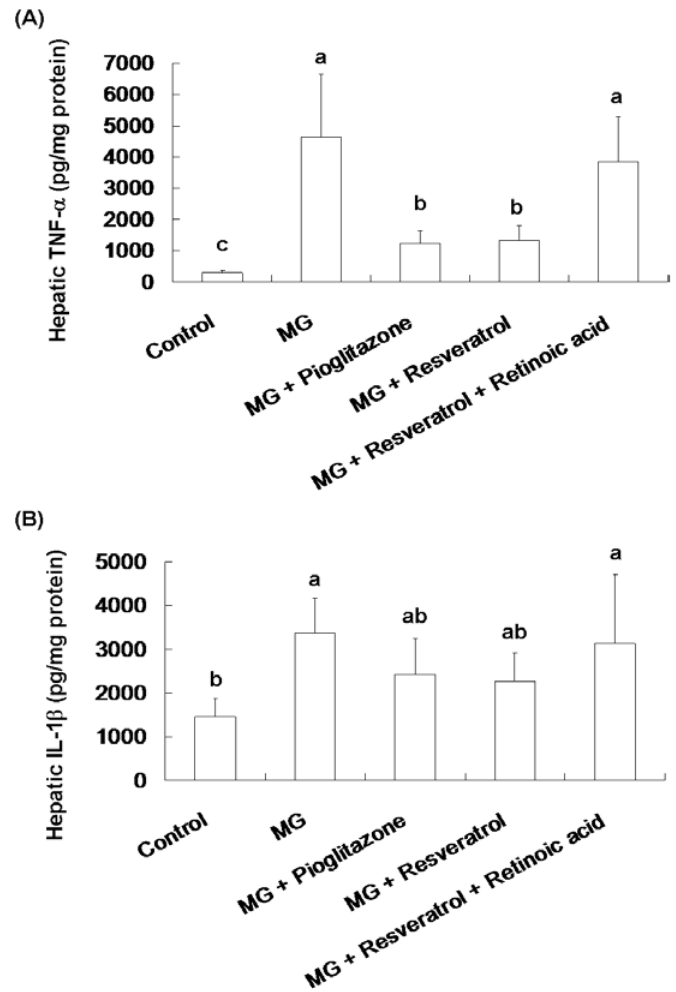
Figure 3. The suppression of inflammatory cytokine levels in the livers of methylglyoxal- treated mice treated with resveratrol. ( A ) Hepatic TNF- α and ( B ) Hepatic IL-1 β levels of methylglyoxal treated mice. The data shown represent the mean ± SD ( n = 6). (a–c) indicate a statistically-significant difference at p <